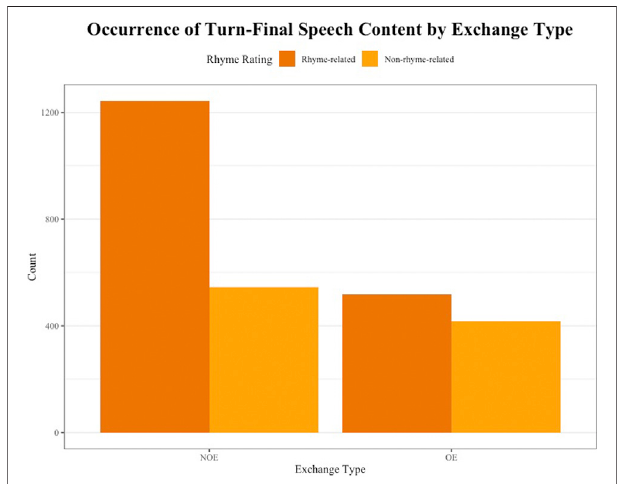
FIGURE 4 | Count of speech content occurrence by exchange type, pooled across